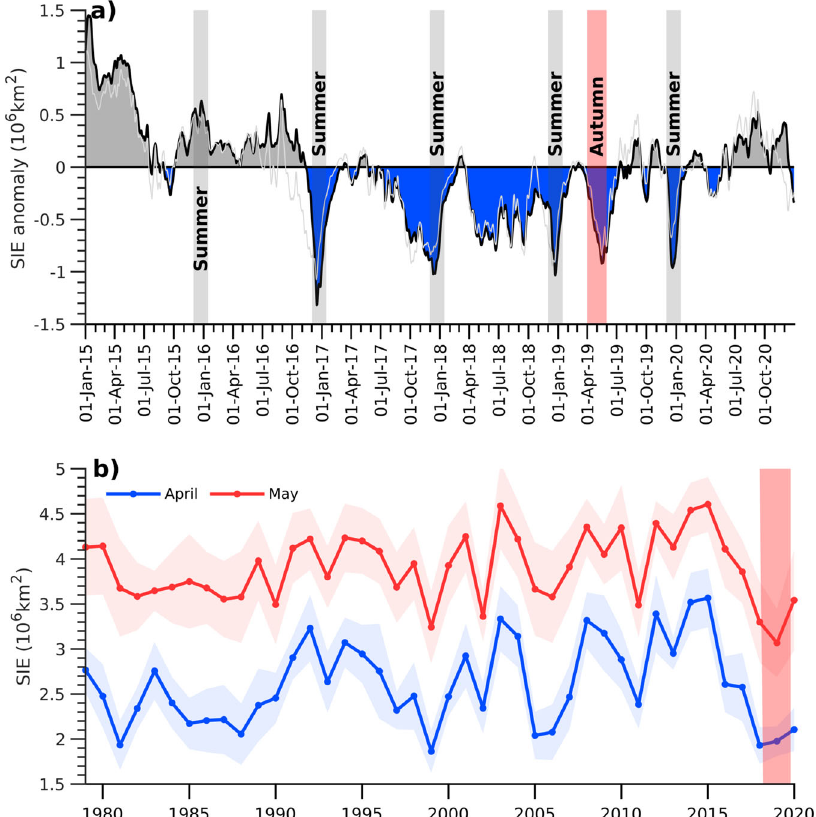
Fig. 1 Sudden declines in sea ice extent (SIE) in the Weddell Sea. a Daily SIE anomalies from 2015 to 2020 relative to the climatology of 1979 – 2008, spatially averaged from 60°W to 20°E and 55°S to the Antarctic coast (Methods section ‘ Sea ice observations ’ ). The light gray line denotes the changes in sea ice area (SIA). The negative (positive) anomalies of SIE are fi lled in blue (dark gray). Vertical gray-shaded bars represent the SIE anomaly in each early summer (1 December – 15 January) with the largest negative values being observed from 16 to 23 December during 2016 – 2020. Vertical red-shaded bar represents the exceptional event of largest negative anomaly in autumn (April – May) 2019. b Interannual variability of mean SIE for April (blue line) and May (red line) with ±1 standard deviation (shade) marked for each year. Vertical red-shade represents the exceptionally low SIE in April and May 2019, considering the entire time series of satellite observations starting from 1979 to